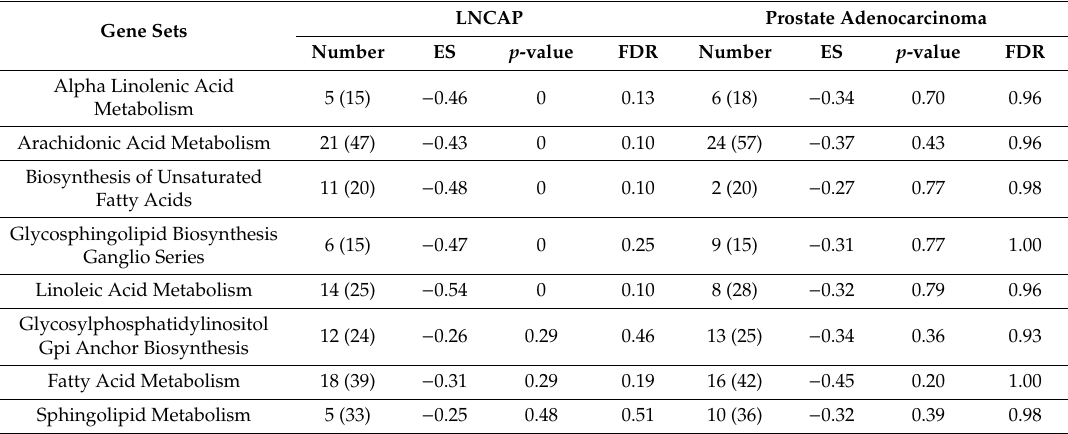
Table 4. Upregulated gene sets in lipid metabolism in the LNCAP cell line and prostate adenocarcinoma